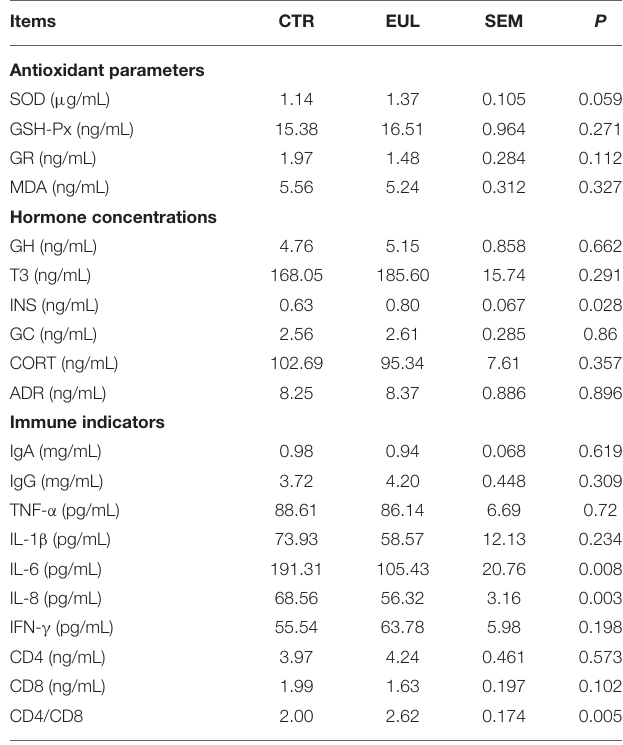
TABLE 2 | Effects of EUL on dry matter intake and milk yield and general composition ( n = 10).